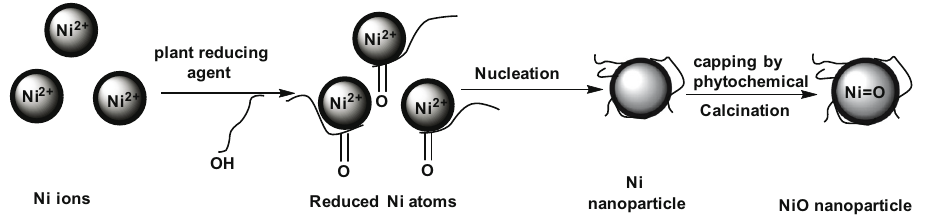
Figure 6: Proposed reaction scheme for the formation of